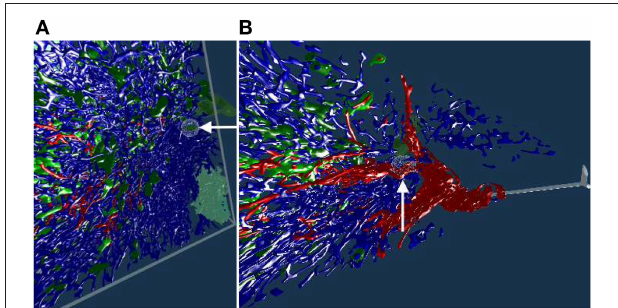
FIGURE 5 | Working with our annotation tool. We show VR screenshots of our application, in a human spleen “sheaths alternating” data set (Steiniger et al., 2021). (A) Overview. In (B) the front plane clipping is evident, viz. Figure 10 . Notice the Valve Index controller with an annotation marker, showing an anatomical structure. In this manner, the VR user can clarify some morphological details or demonstrate an issue to an audience outside VR. The annotation marker in this case is a white ball, painted with thin mesh lines. All images are produced with our VR tool. Similar illustrations can be found in Steiniger et al. (2021).